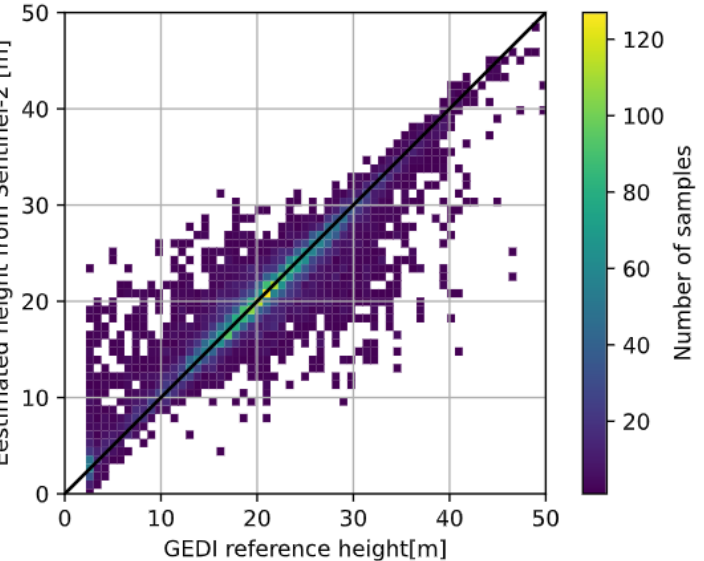
Figure 6. Relationships between the estimated canopy top height from Sentinel-2 and the GEDI reference